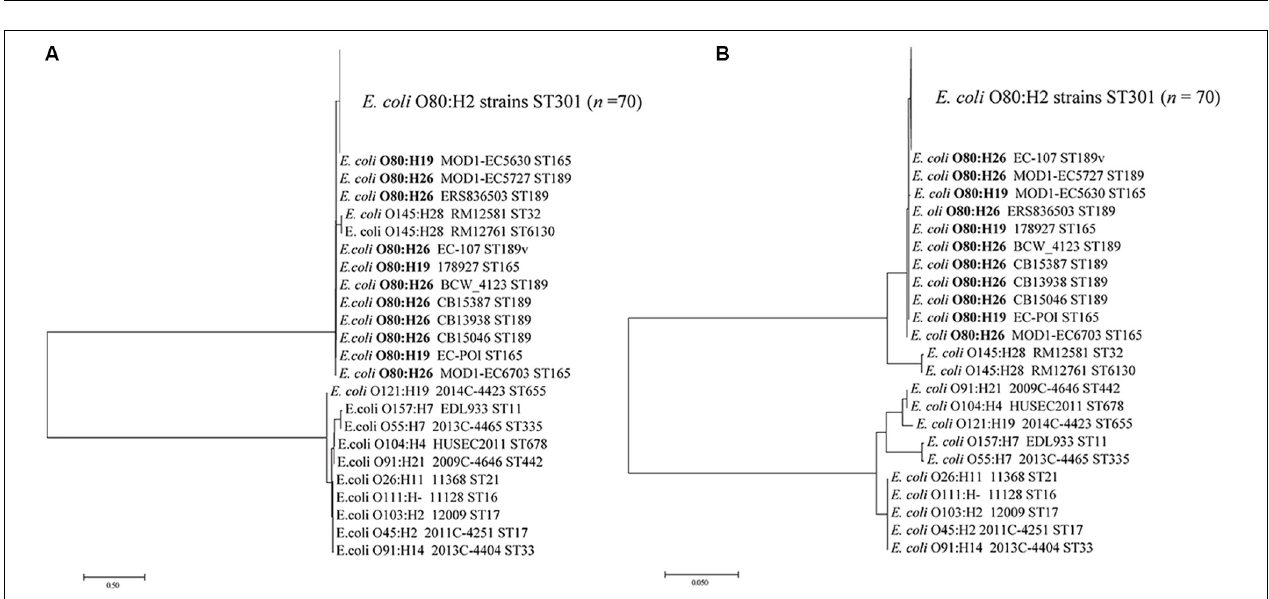
FIGURE 3 | Minimum spanning tree of CTs for 70 STEC O80:H2 strains by geographical region (A) , host source (B) , or disease status (C) . Each nodal point represents one CT, and the size represents the number of strains within the CT, whereas the branch and distribution of all the CTs indicate the relationship among these CTs. Different geographical region (A) , host sources (B) , or disease status (C) correspond to a color indicated in the legend in the right upper side.